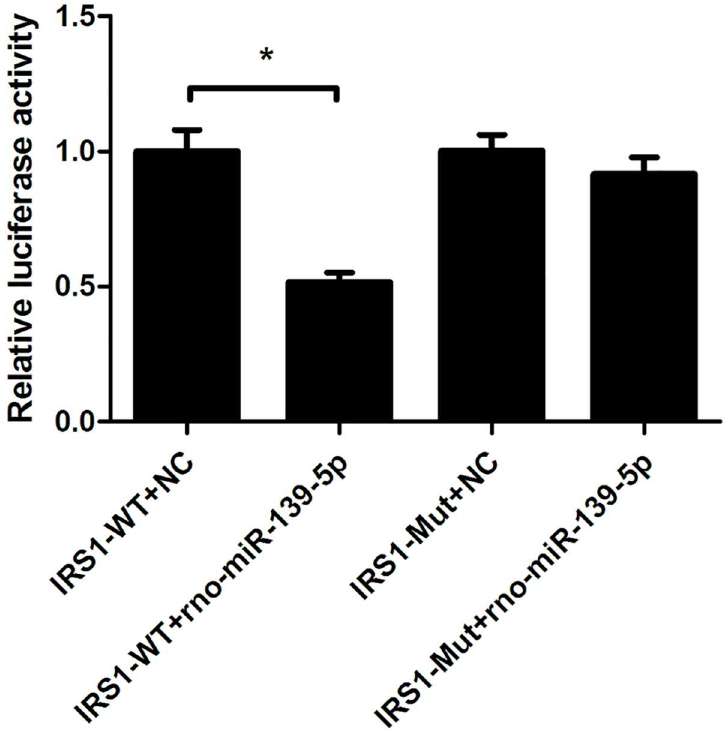
Fig 11. Dual-luciferase reporter assay of IRS1 and rno-miR-139-5p (n = 3, p < 0.05). Cells were cotransfected with the luciferase reporter vector containingwild-type(IRS1-WT) or mutated (IRS1-Mut) 3’- UTR of IRS1 and miR-139-5pmimic (miR-139-5p)or control oligonucleotides (NC). Data are shown as means ± SD of three independent experiments. It demonstrated that miR-139-5p inhibitedthe IRS1 expressionby interactingwith the 3’-UTR of IRS1.